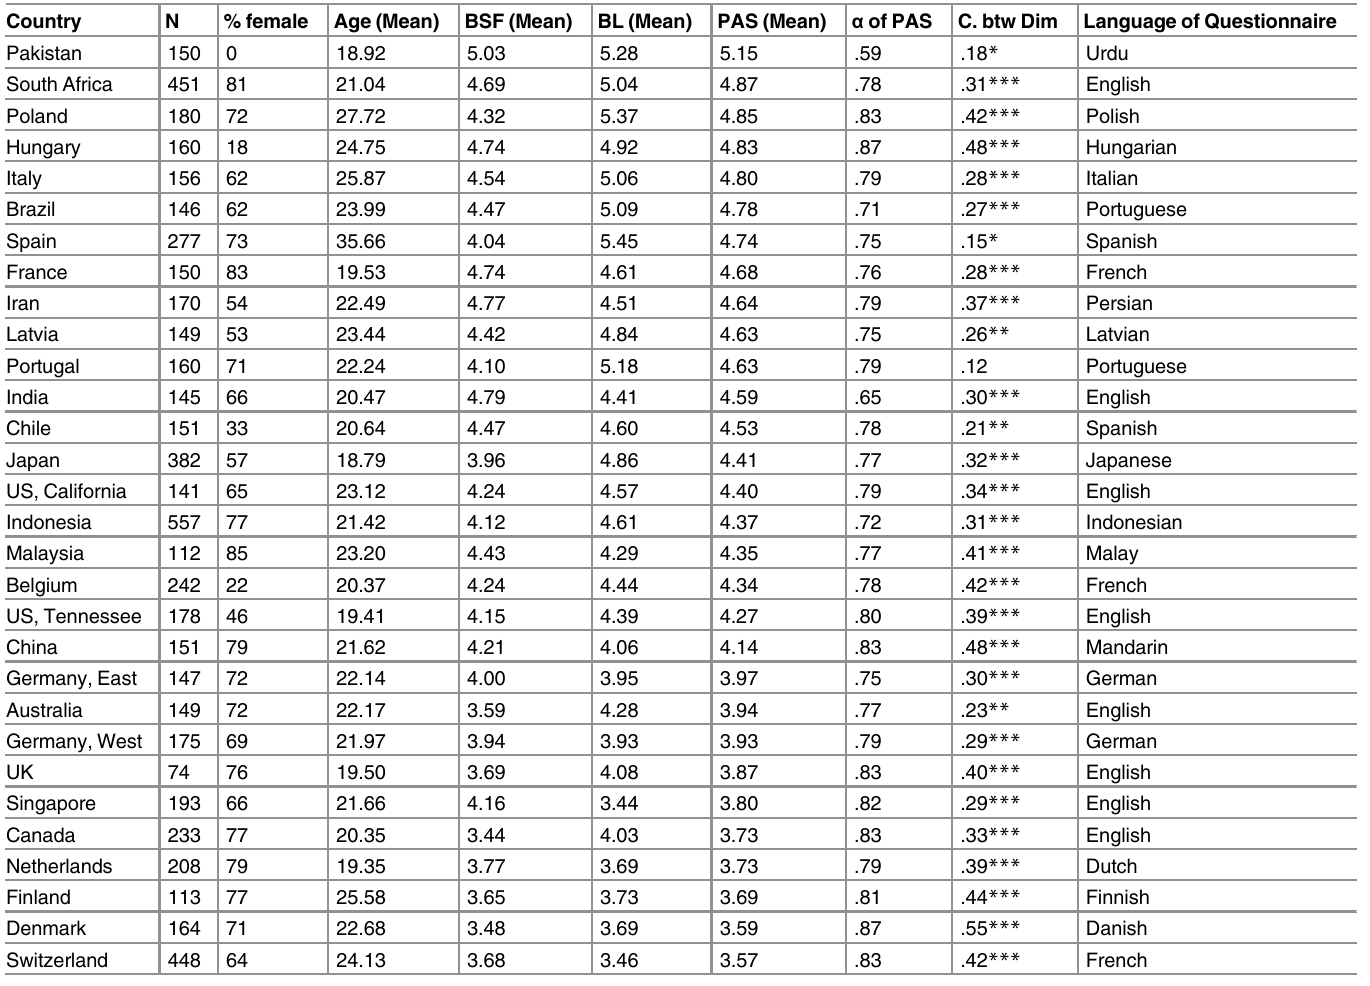
Table 4. Country-level descriptive statistics (Ordered based by PAS